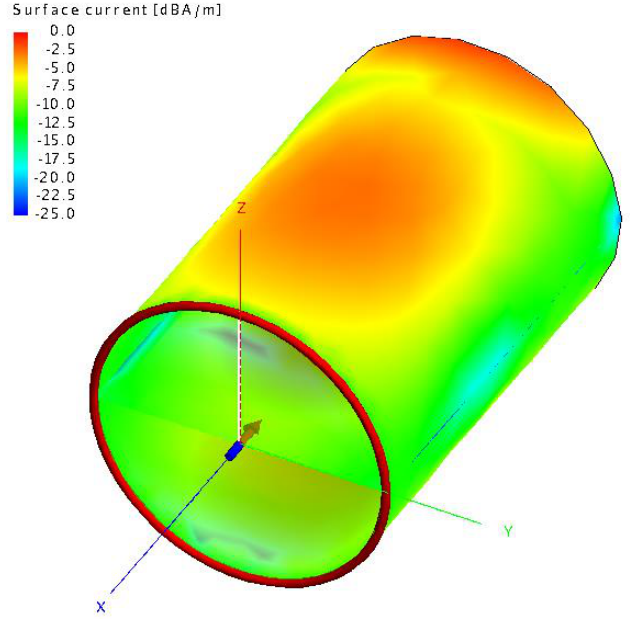
Fig. 5. Distribution of current amplitudes in a circular waveguide at a frequency of 100